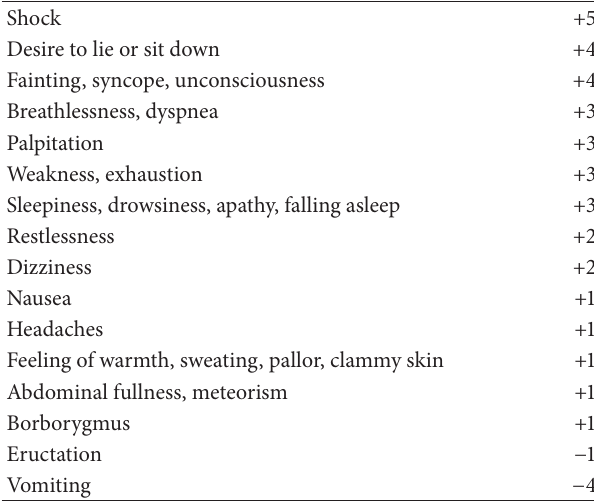
Table 1: Correlation of dumping symptoms following a meal within the Sigstad scoring